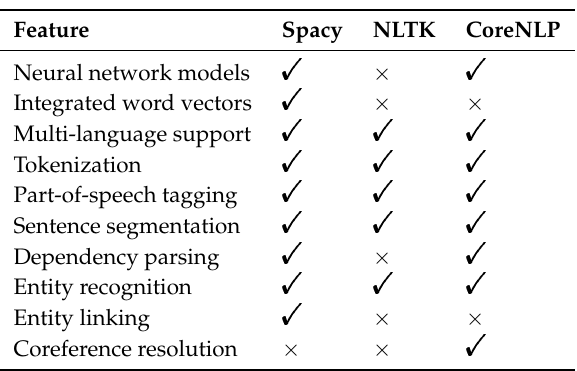
Table 2. Feature comparison between different NLP